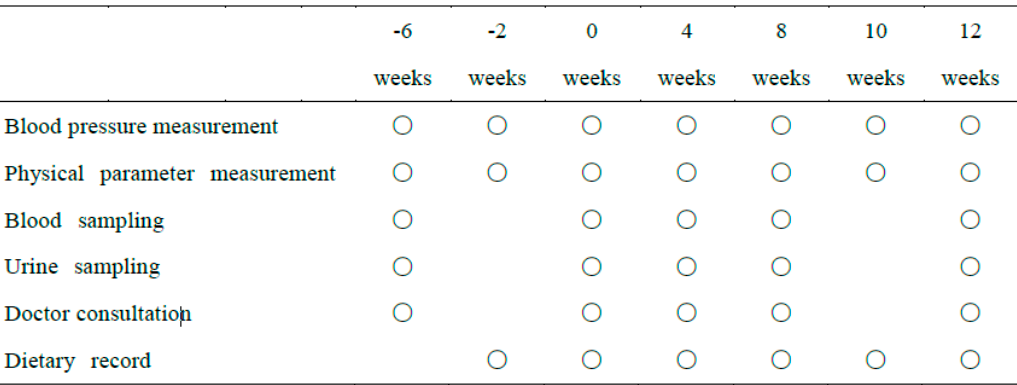
Figure 2. Test session schedule. Circles represent when data or samples were measured or collected.